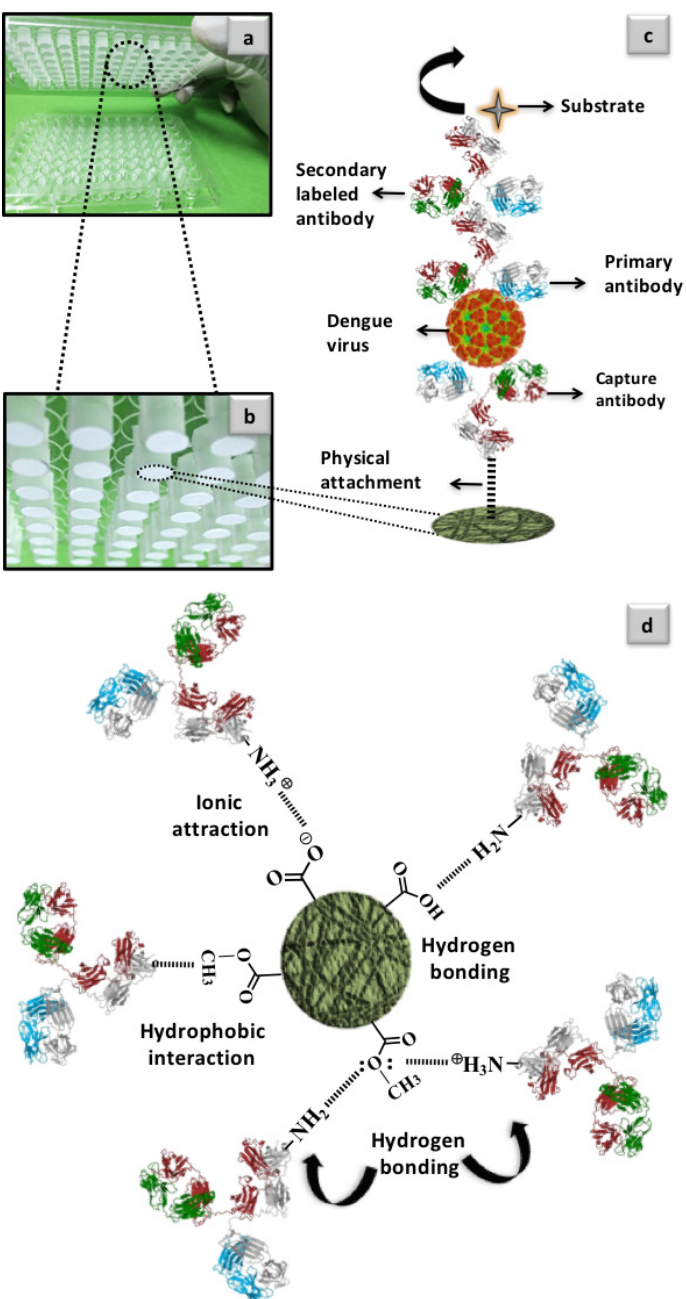
Figure 4. Application of i-ELISA platform in sandwich assay: ( a , b ) i-ELISA principle and magnified PHBV fiber mat through direct (physical) attachment of the biomolecules to the surface; and ( d ) major forces that contribute in the biomolecular interaction via surface functional